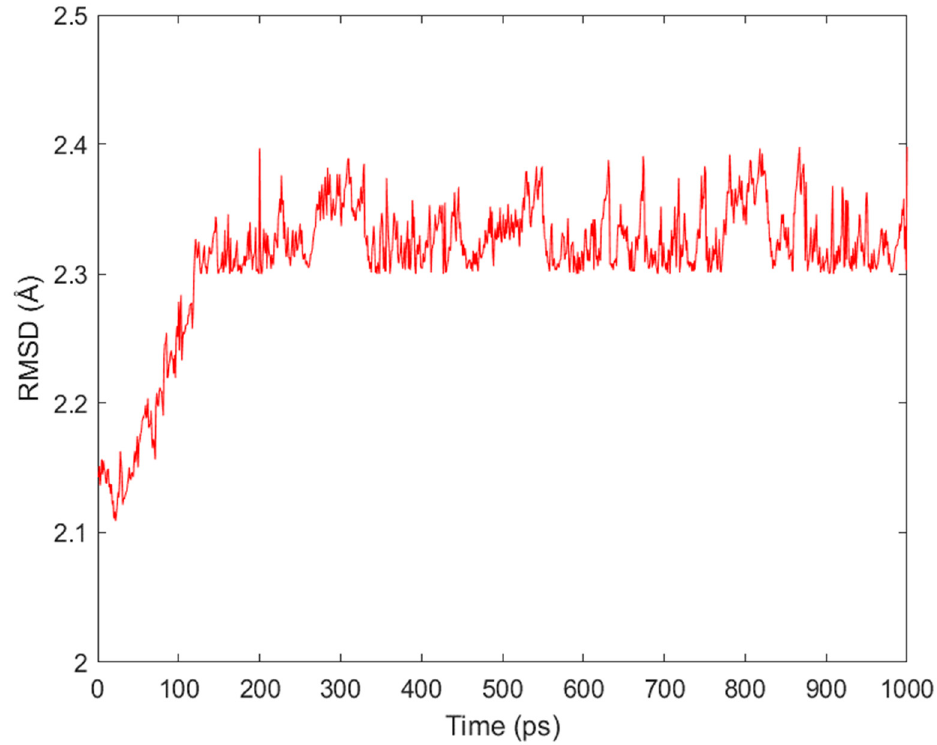
Figure 1. Average all-atom root-mean-square deviation (RMSD) calculated over time for the Hyp-1 protein structure during 1 ns of NPT equilibration. The values shown were averaged over 64 monomers in the crystal.